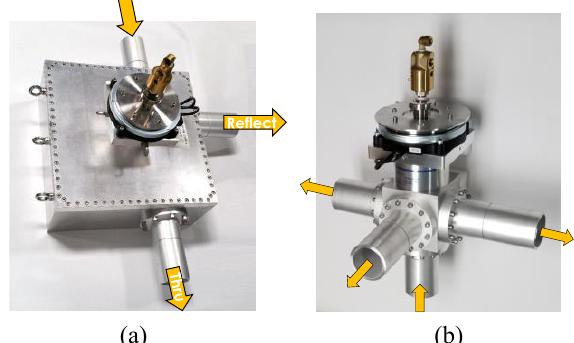
Fig. 7. In-plane (a) and out-of-plane (b) motorized rotary waveguide switches for high power